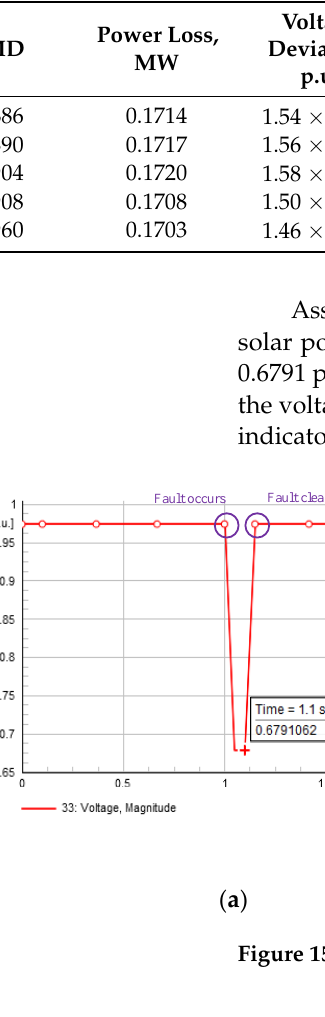
Table 6. Best five neighboring solutions obtained by the Manhattan distance method (one BESS connection).